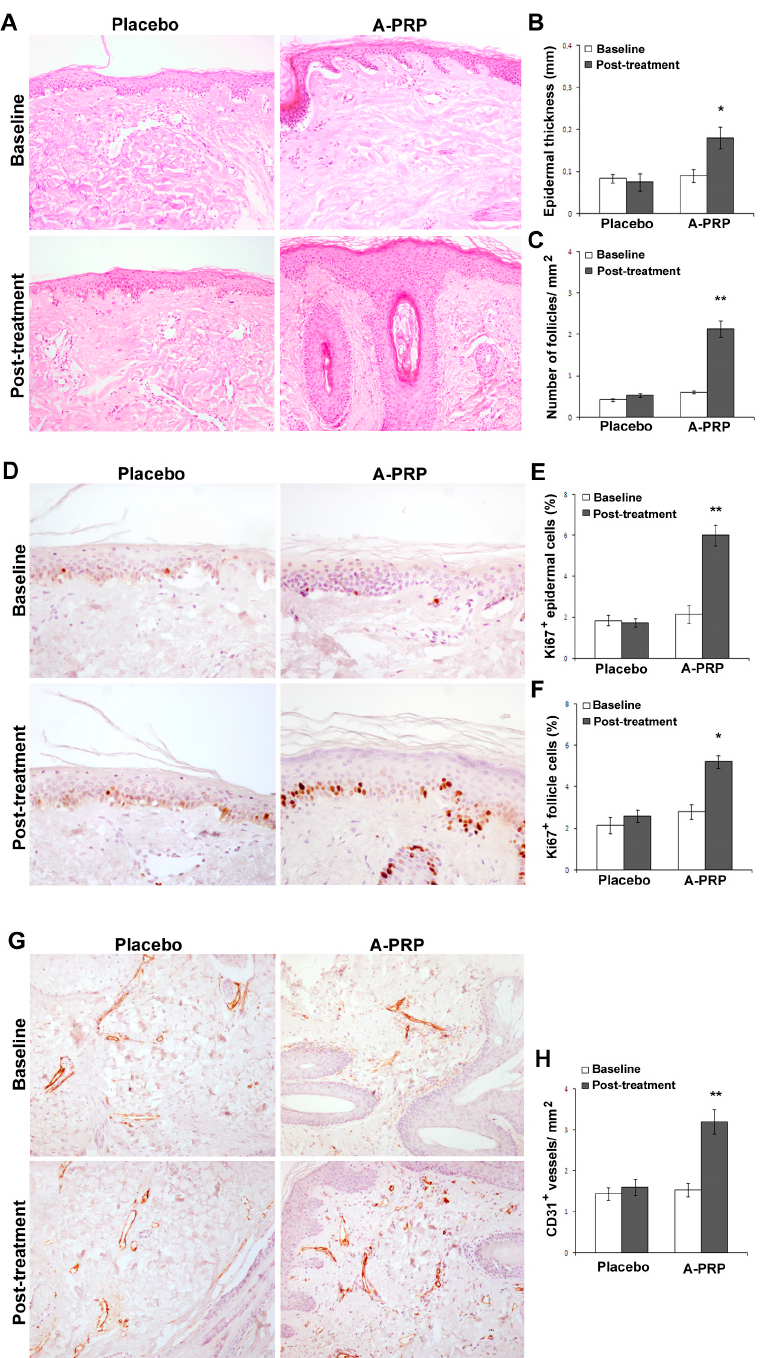
Figure 1. A-PRP treatment increased proliferation of epidermis basal cells and follicular bulge cells as well as vascularization. ( A ) Representative microphotographs of hematoxylin and eosin stained tissue sections from placebo and A-PRP treated scalp biopsies at baseline and two weeks post-treatment (original magnification 100×); ( B , C ) Morphometric evaluation of epidermis thickness (mm) and hair follicle density (no follicles mm − 2 ); ( D ) Representative microphotographs of Ki67 + immunostaining of scalp biopsies from placebo and A-PRP treated patients at baseline and two weeks post-treatment (original magnification 200×); ( E , F ) The percentage of proliferating Ki67 + epidermal and follicle cells (dark brown nuclei); ( G ) Representative microphotographs of CD31 immunostaining of scalp biopsies from placebo and A-PRP treated patients at baseline and two weeks post-treatment (original magnification 100×); ( H ) Capillary density (CD31 + vessels mm − 2 ). * and ** indicates p < 0.05 and p < 0.01, respectively.